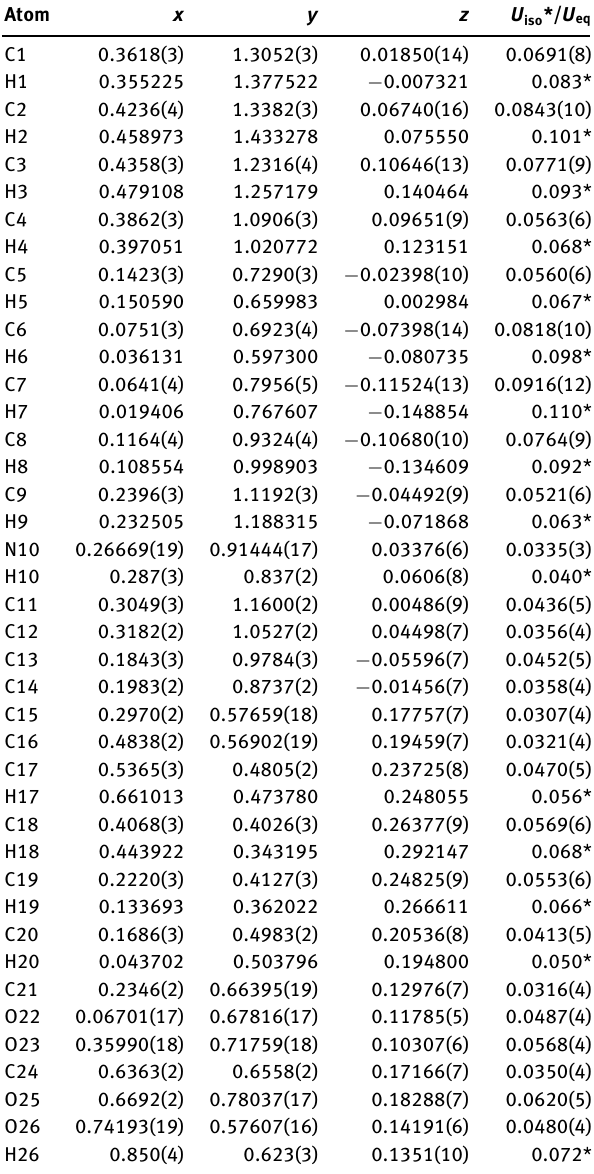
Table 2: Fractional atomic coordinates and isotropic or equivalent isotropic displacement parameters (Å 2